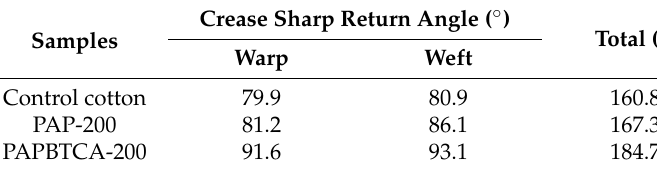
Table 4. Crease recovery angle test of the control, PAP-200, and PAPBTCA-200.